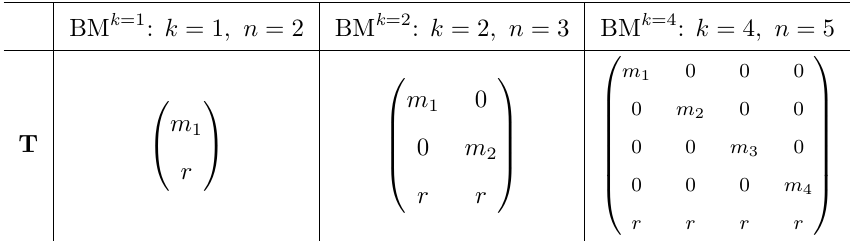
for the packed BM instances. 2 8